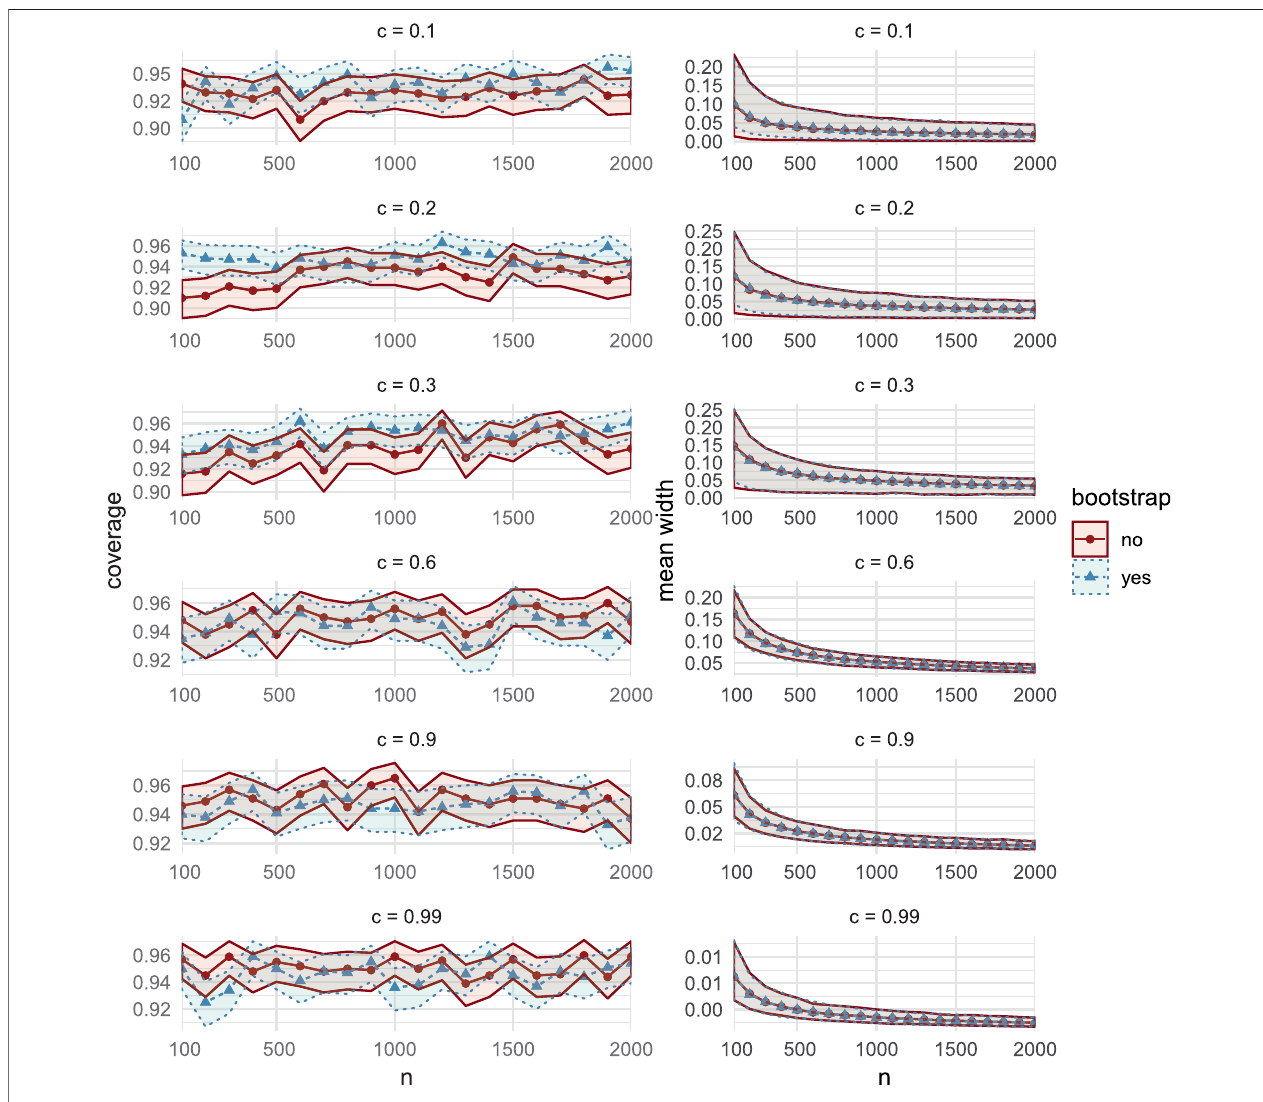
FIGURE 15 | Comparisons of coverage (left column) and mean width (right column) , between the bootstrap CIs (dashed lines with triangular markers) and the asymptotic CIs (solid lines with circular markers) in MC Study C. Rows represent correlations c, increasing from 0:1 on the top row to 0:99 on the bottom row. The horizontal axes display the sample sizes n (cid:2) 100; 200;